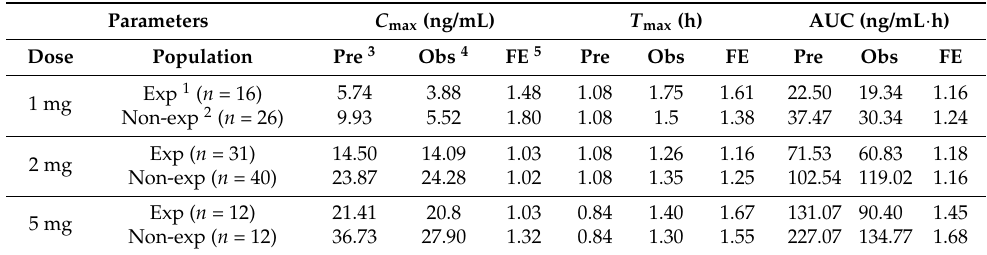
Table 1. Simulation results of tacrolimus with different doses.